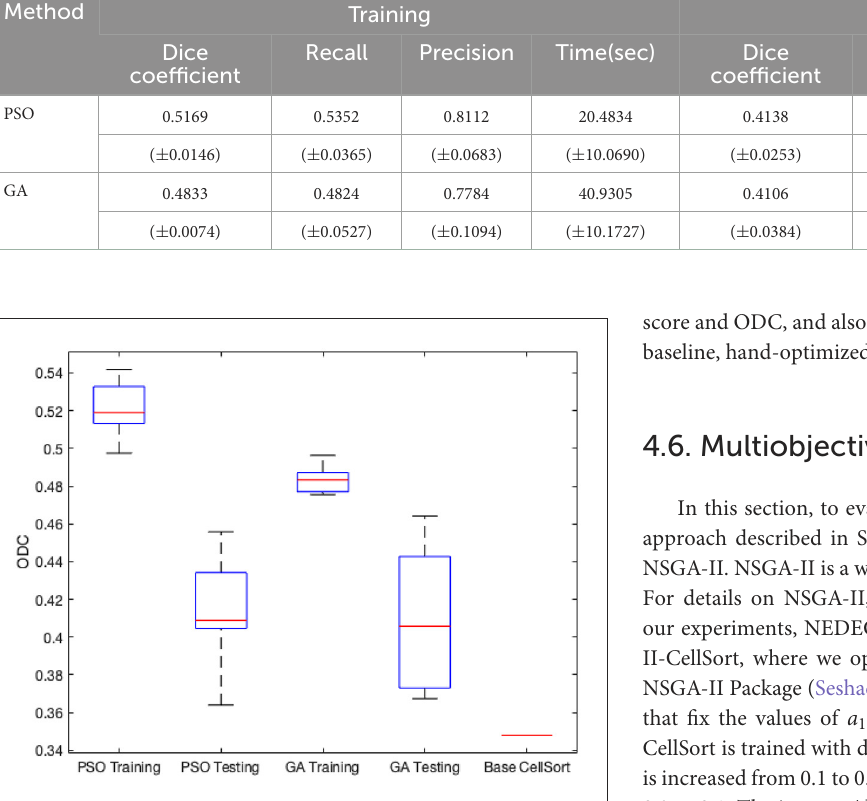
FIGURE7 Minimum, maximum, quartiles and average of the ODC over all k = 3 experimental groups for